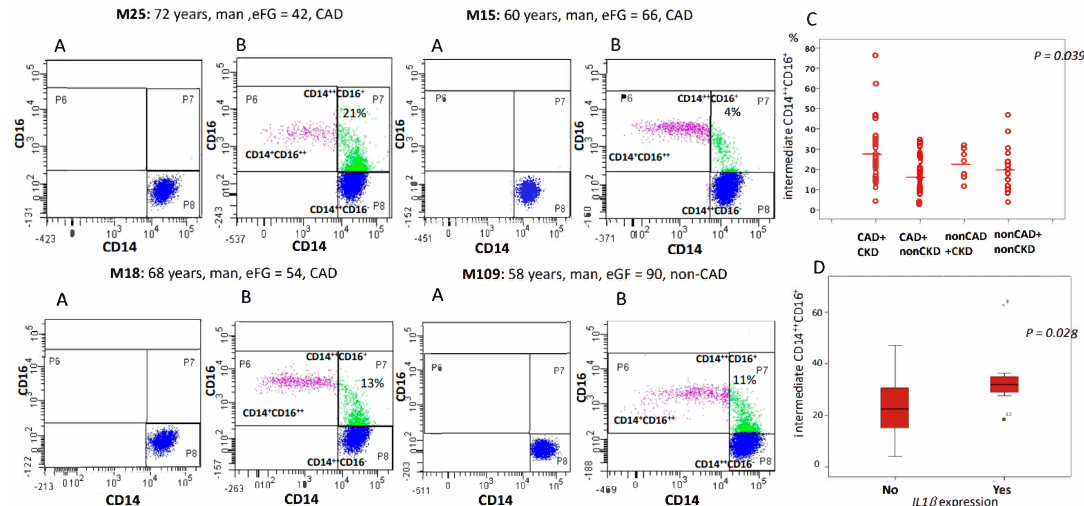
Figure 4. Flow cytometric analysis demonstrating human monocyte heterogeneity. Representative Flow cytometry plots for classical (CD14 ++ CD16 − ), intermediate (CD14 ++ CD16 + ) and nonclassical monocytes (CD14 + CD16 ++ ) from four di ff erent patients. In all the cases, panels ( A ) represent the fluorescence minus one (FMO) negative control, while panels ( B ) represent monocyte subpopulations in the patient tested. Panel ( C ): dot-blot graphic showing the percentage of intermediate CD14 ++ CD16 + monocytes from each study group. ( D ): Percentage of intermediate CD14 ++ CD16 + monocytes according to the expression of IL1 β . Abbreviations: CAD = coronary artery disease, NonCAD = patients without CAD, CKD = chronic kidney disease, NonCKD = patients with eFG > 60 mL / min. p value was calculated using the ANOVA test or U-Mann–Whitney